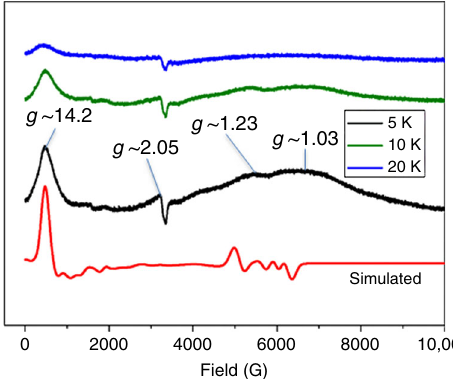
Fig. 4 EPR spectroscopy. Powder EPR spectra of 1 at X-band frequency at 5, 10, and 20 K and the simulated